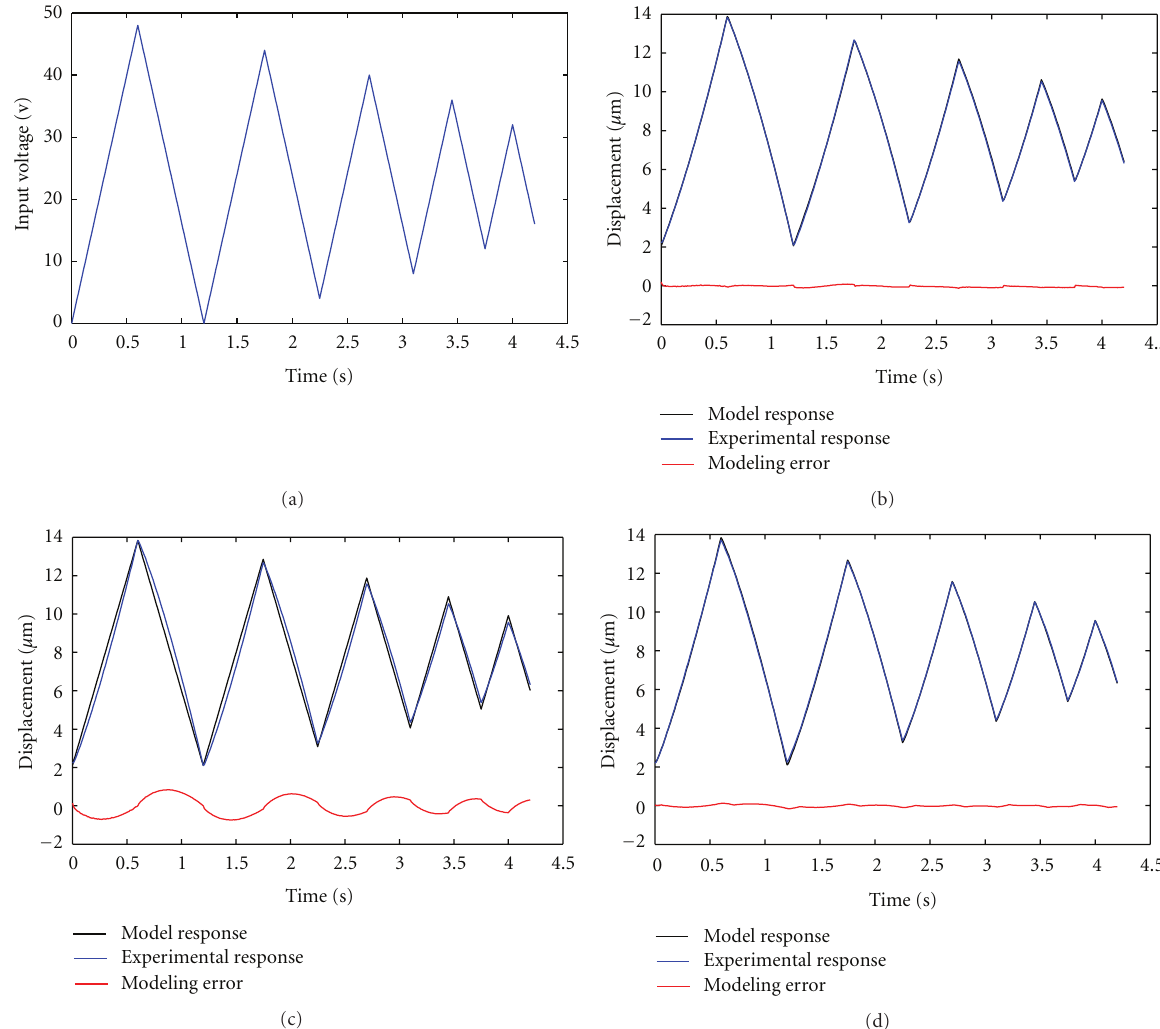
Figure 3: (a) The first-order reversal signal. (b) The experimental response and the proposed model response. (c) The experimental response and the linear model response, and (d) the experimental response and the PI model response.